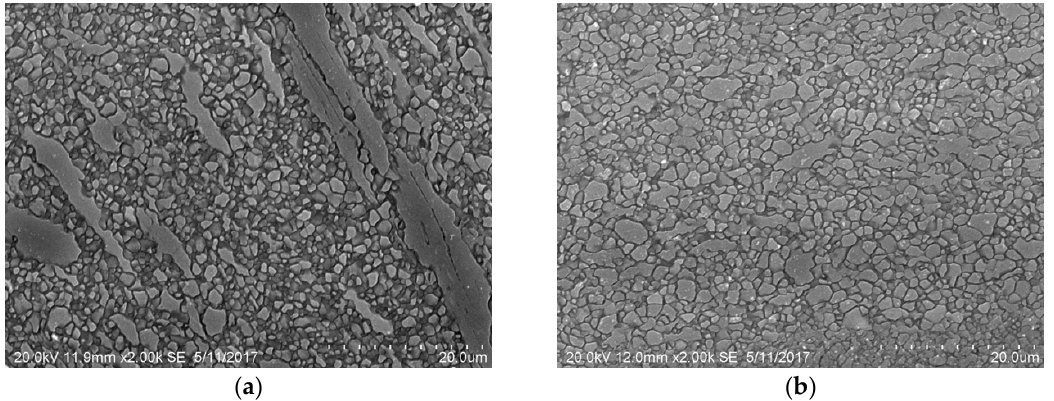
Figure 13. Microstructures of AZ31 after two sc-ECAE passes at temperatures of 250 °C ( a ) and 275 °C ( b ). The large grains in ( a ) are oriented along the extrusion direction.